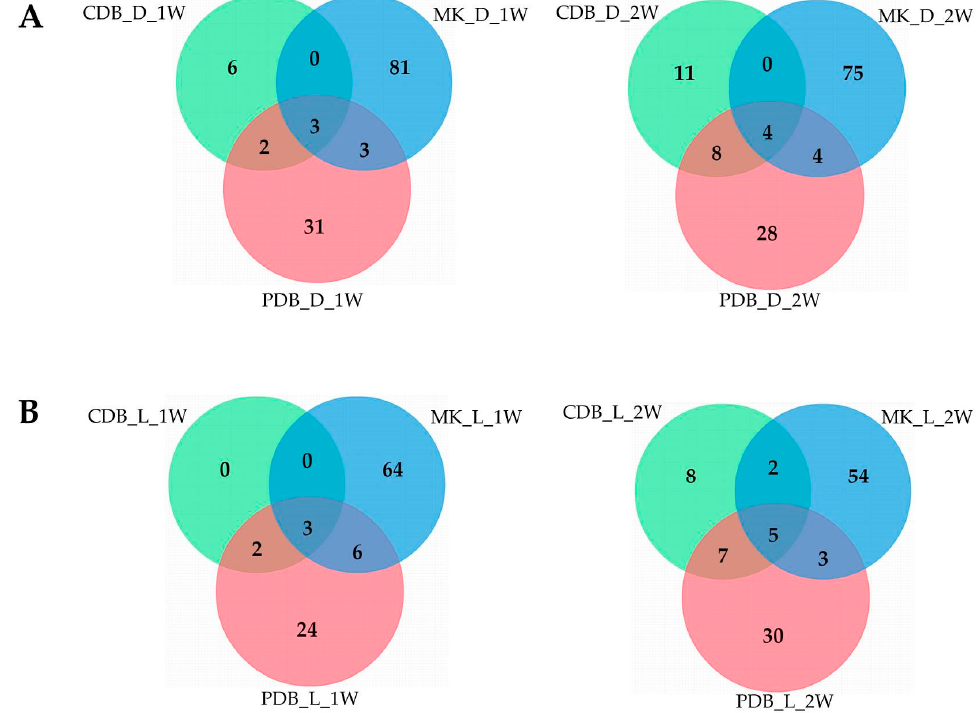
Figure 2. Venn diagrams showing the number of unique and overlapping products in A1021B cultures under the di ff erent growth conditions. ( A ) Secondary metabolites (SMs) produced in darkness (d) after one (1 w) or two weeks (2 w). ( B ) SMs produced under light exposure (l) after one (1 w) or two weeks (2 w). MK = maize kernels; CDB = Czapek-Dox broth; PDB = potato dextrose